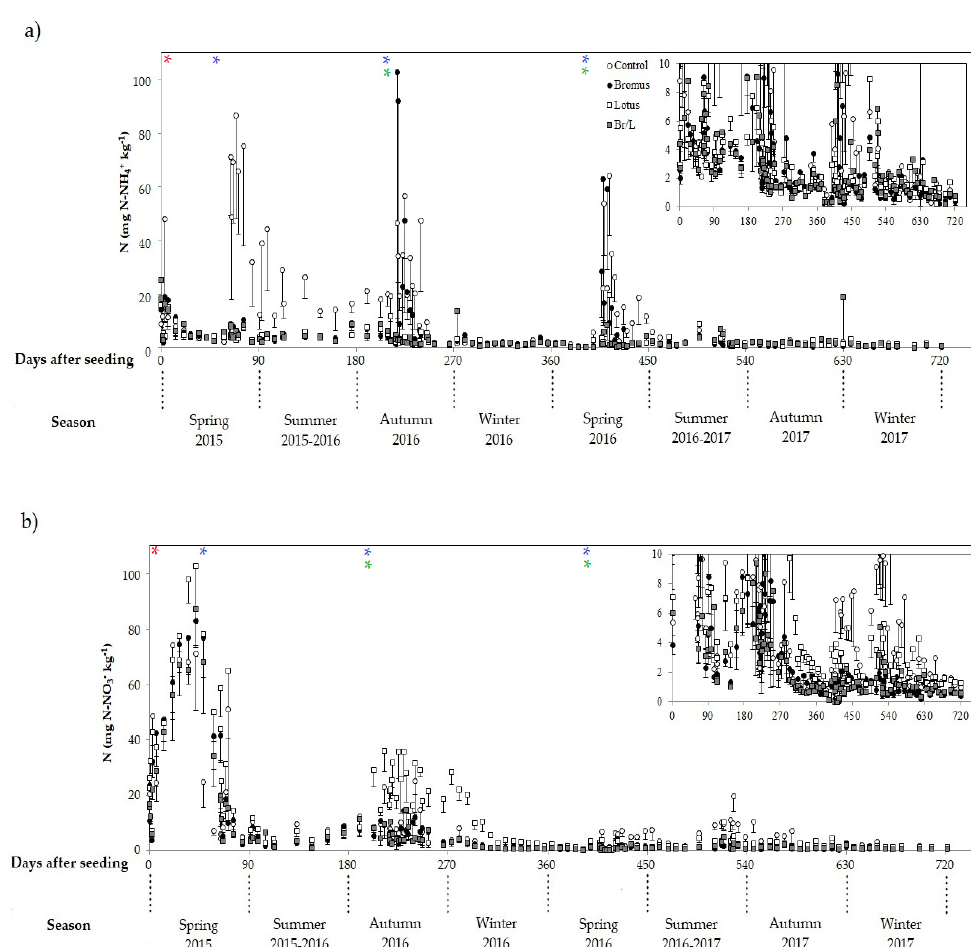
Figure 2. Concentration of soil available N as ( a ) ammonium (N–NH 4+ ) and b ) nitrate (N–NO 3 − ) (mg N kg − 1 dry soil, 0–20 cm, ± standard error of the mean, n = 5) during the experimental period (September 2015–September 2017). Original data with no interpolation. Red, blue and green asterisks indicate N application to all treatments, control treatment and to Bromus, respectively. The inserts show low concentrations (<10 mg N kg − 1 dry soil) across the experimental